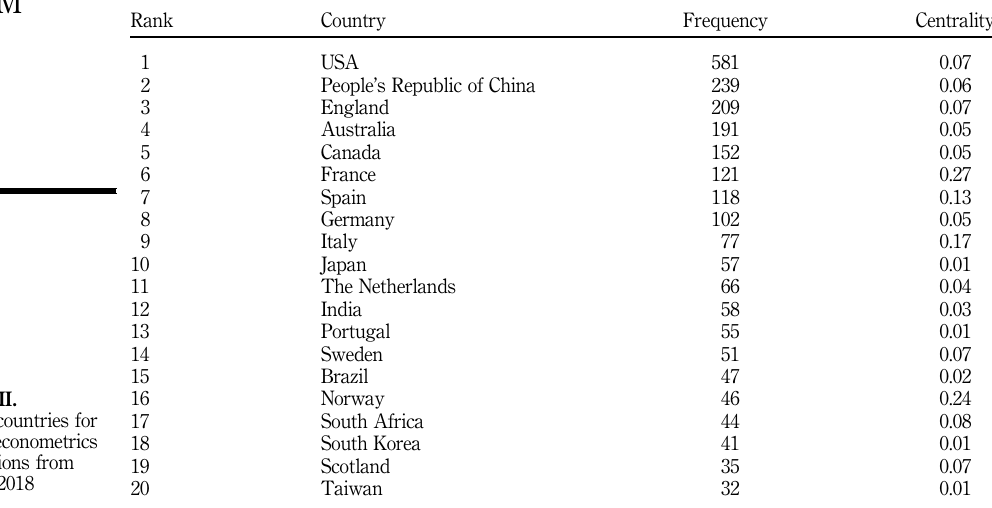
Table III. Top 20 countries for marine econometrics publications from